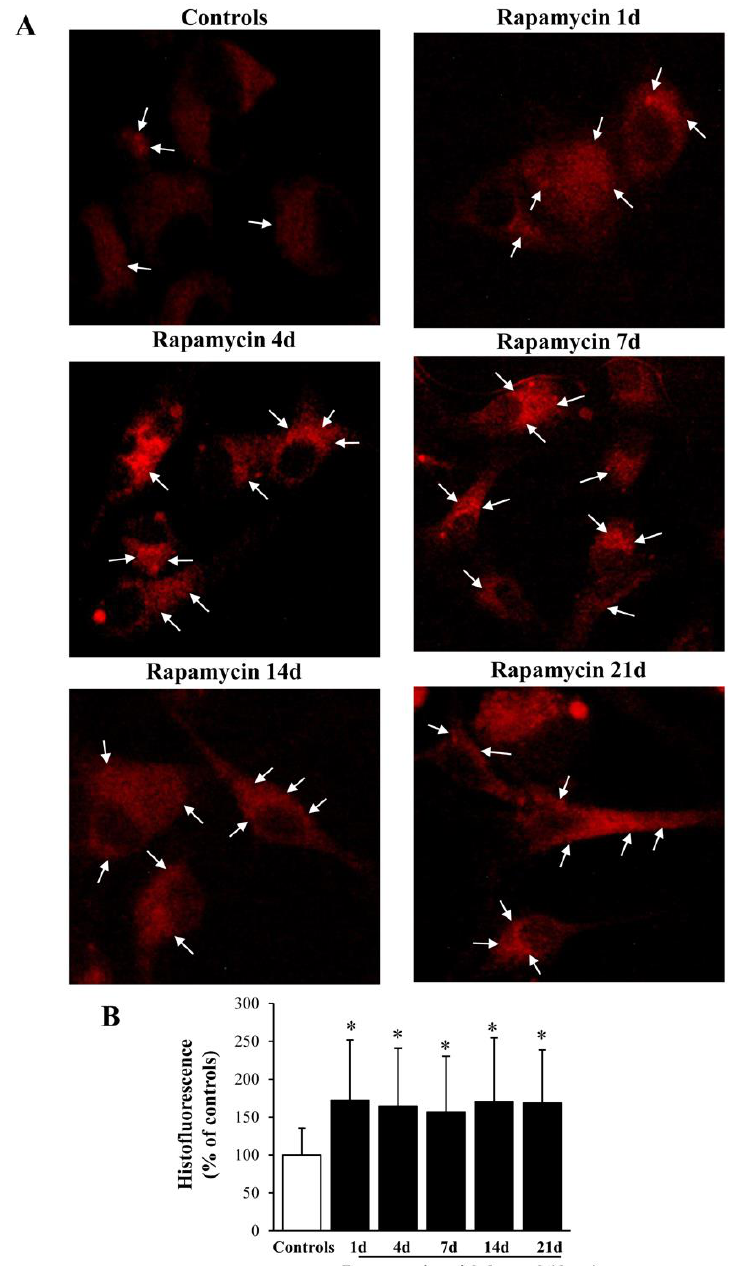
Figure 2. During rapamycin withdrawal a persistent increase in the amount of healthy mitochondria takes place. ( A ) Representative pictures stained with MTR showing healthy mitochondria (arrows) from controls or rapamycin (10 nM for 24 h) at various time intervals following withdrawal (from 1 d up to 21 d). It is evident how rapamycin treatment produces increased fluorescence, which is steady at various time intervals. This is counted in the graph ( B ), which reports the percentage of MTR histofluorescence compared with control, which persists steadily elevated up to 21 d. Counts represent the mean ± SD from N = 50 cells per group. ∗ p ≤ 0.05 compared with control. Scale Bar = 20 μ m.